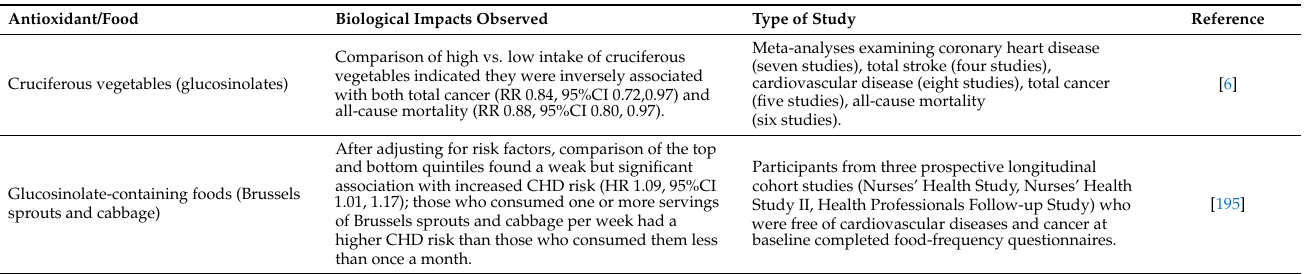
Glucosinolate-containing foods (Brussels sprouts and